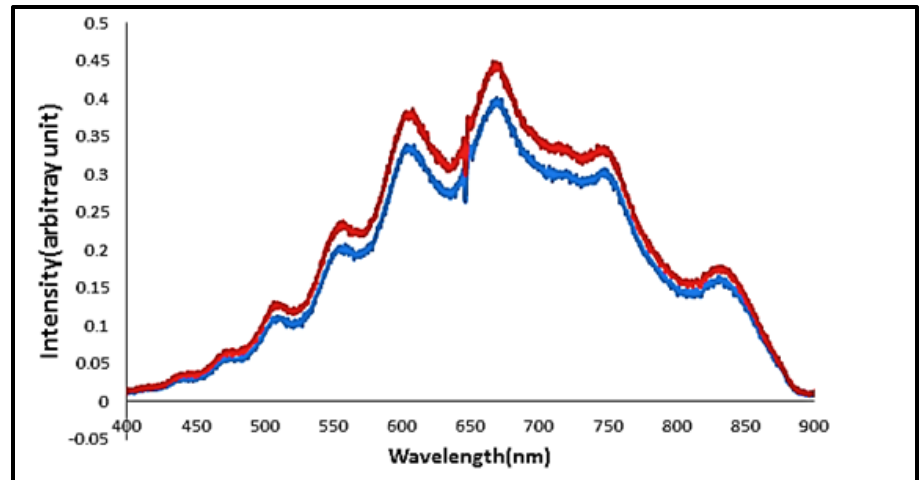
Fig.8: Spectra of the polychromatic light through the sensor measured using the spectrum analyzer; red line for sensitive region of optical fiber in air, blue line for sensitive region dipped in a solution of refractive index n =